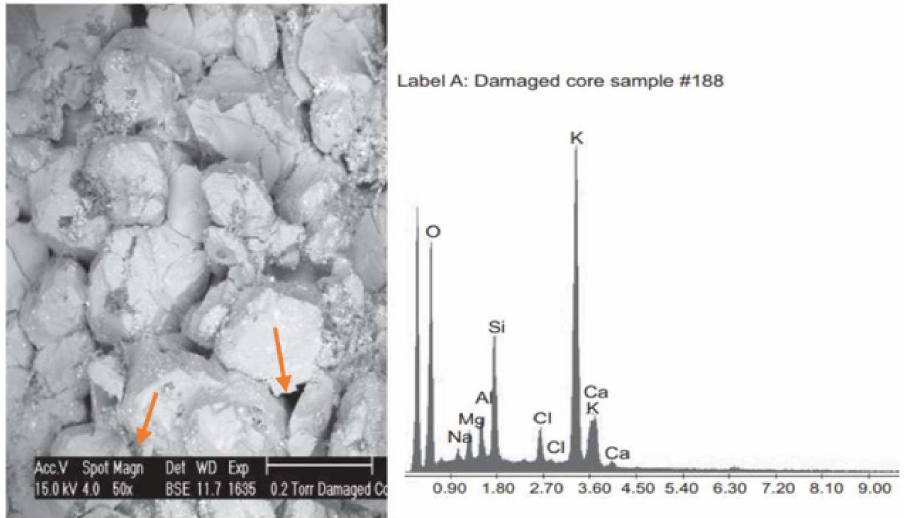
Figure 8. ESEM photomicrograph and EDS analysis showing potassium chloride precipitation within the pore structures of the reservoir